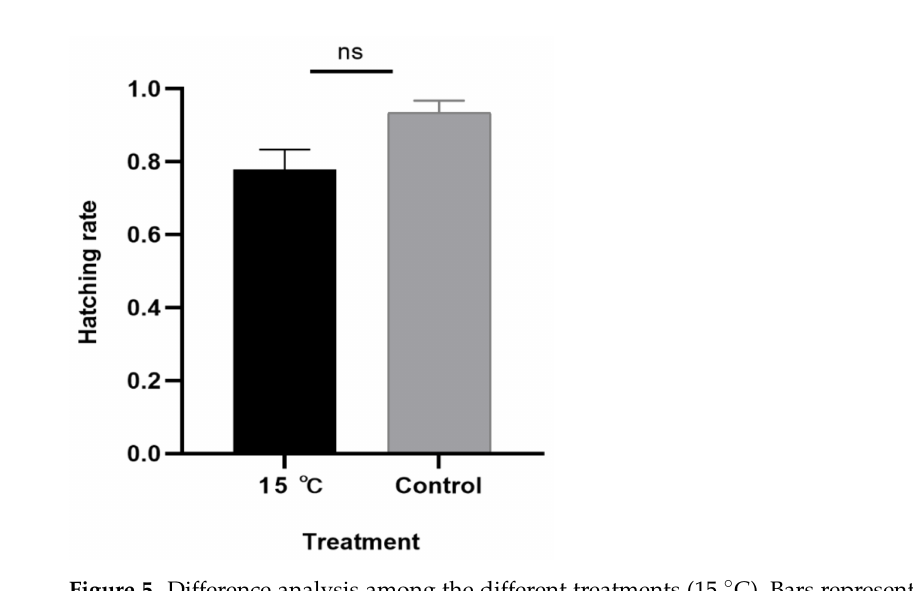
Figure 5. Difference analysis among the different treatments (15 ◦ C). Bars represent the standard error. Student’s t-test ( p < 0.05) was used to test whether the hatch rate of eggs stored at 15 ◦ C was significant different from the control group ( p = 0.074).